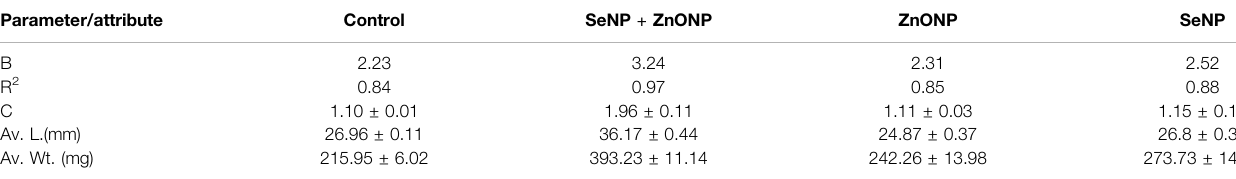
TABLE 2 | Growth parameters like average length (L) (mm) and weight (Wt) (mg) and the condition factor (FCF) for each treatment. Values (C, L, and Wt) are mean ± standard deviation. Parameter/attribute